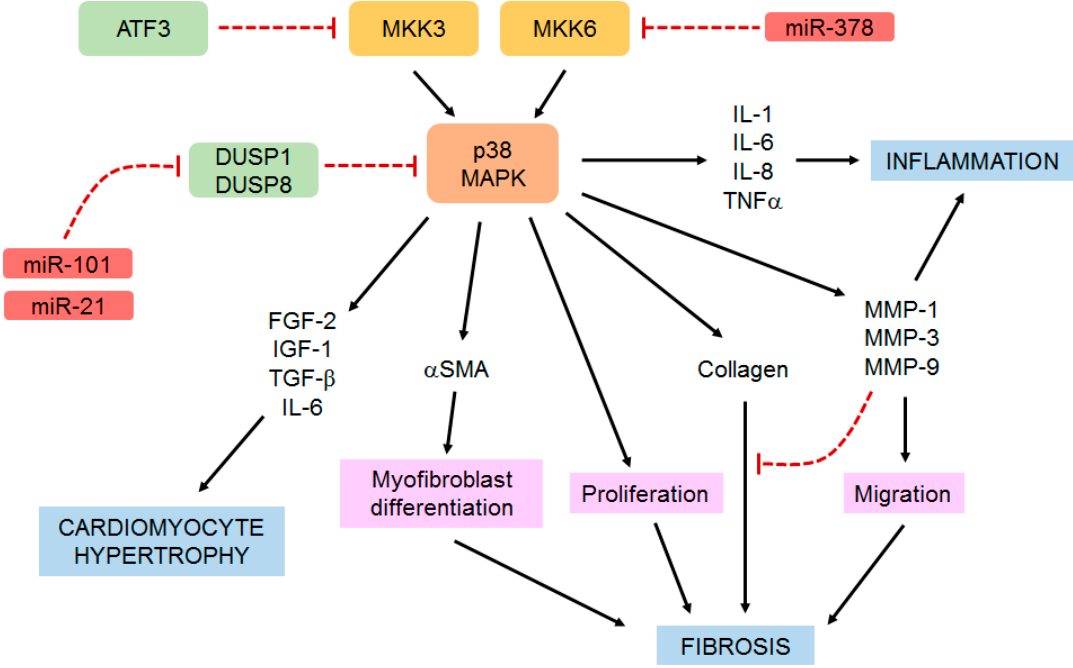
Figure 3. Central role of p38 in regulating cardiac fibroblast function. Cardiac fibroblast p38 is